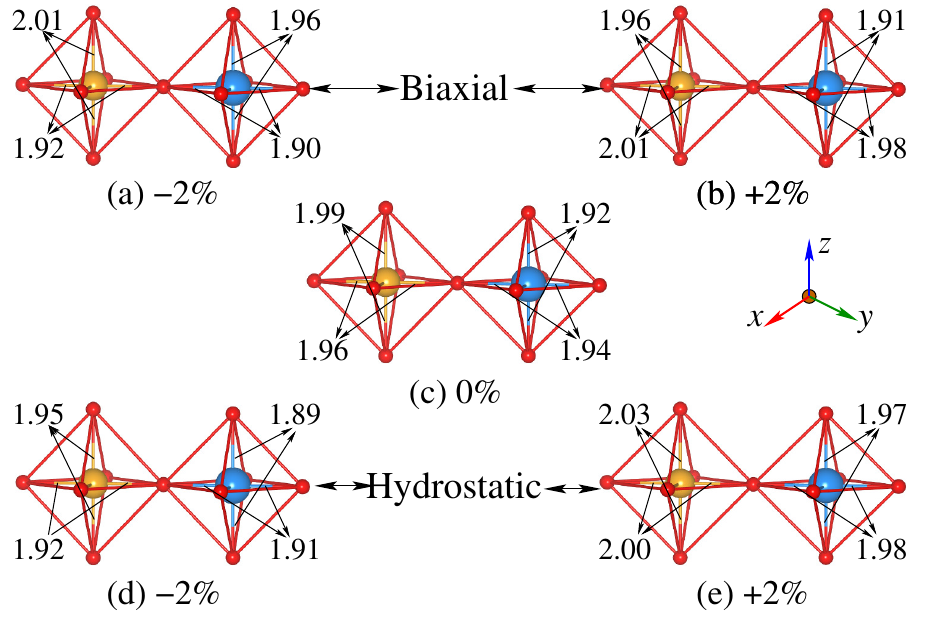
Figure 10. Locally distorted CrO 6 ( ReO 6 ) octahedron in Sr 2 CrReO 6 systems for ( a ) − 2% and ( b ) + 2% biaxial strains along the [110]-direction, ( c ) 0% (unstrained), and ( d ) − 2% and ( e ) + 2% hydrostatic strains along the [111]-direction. The x , y , and z -axes are along the crystallographic a , b , and c -directions,